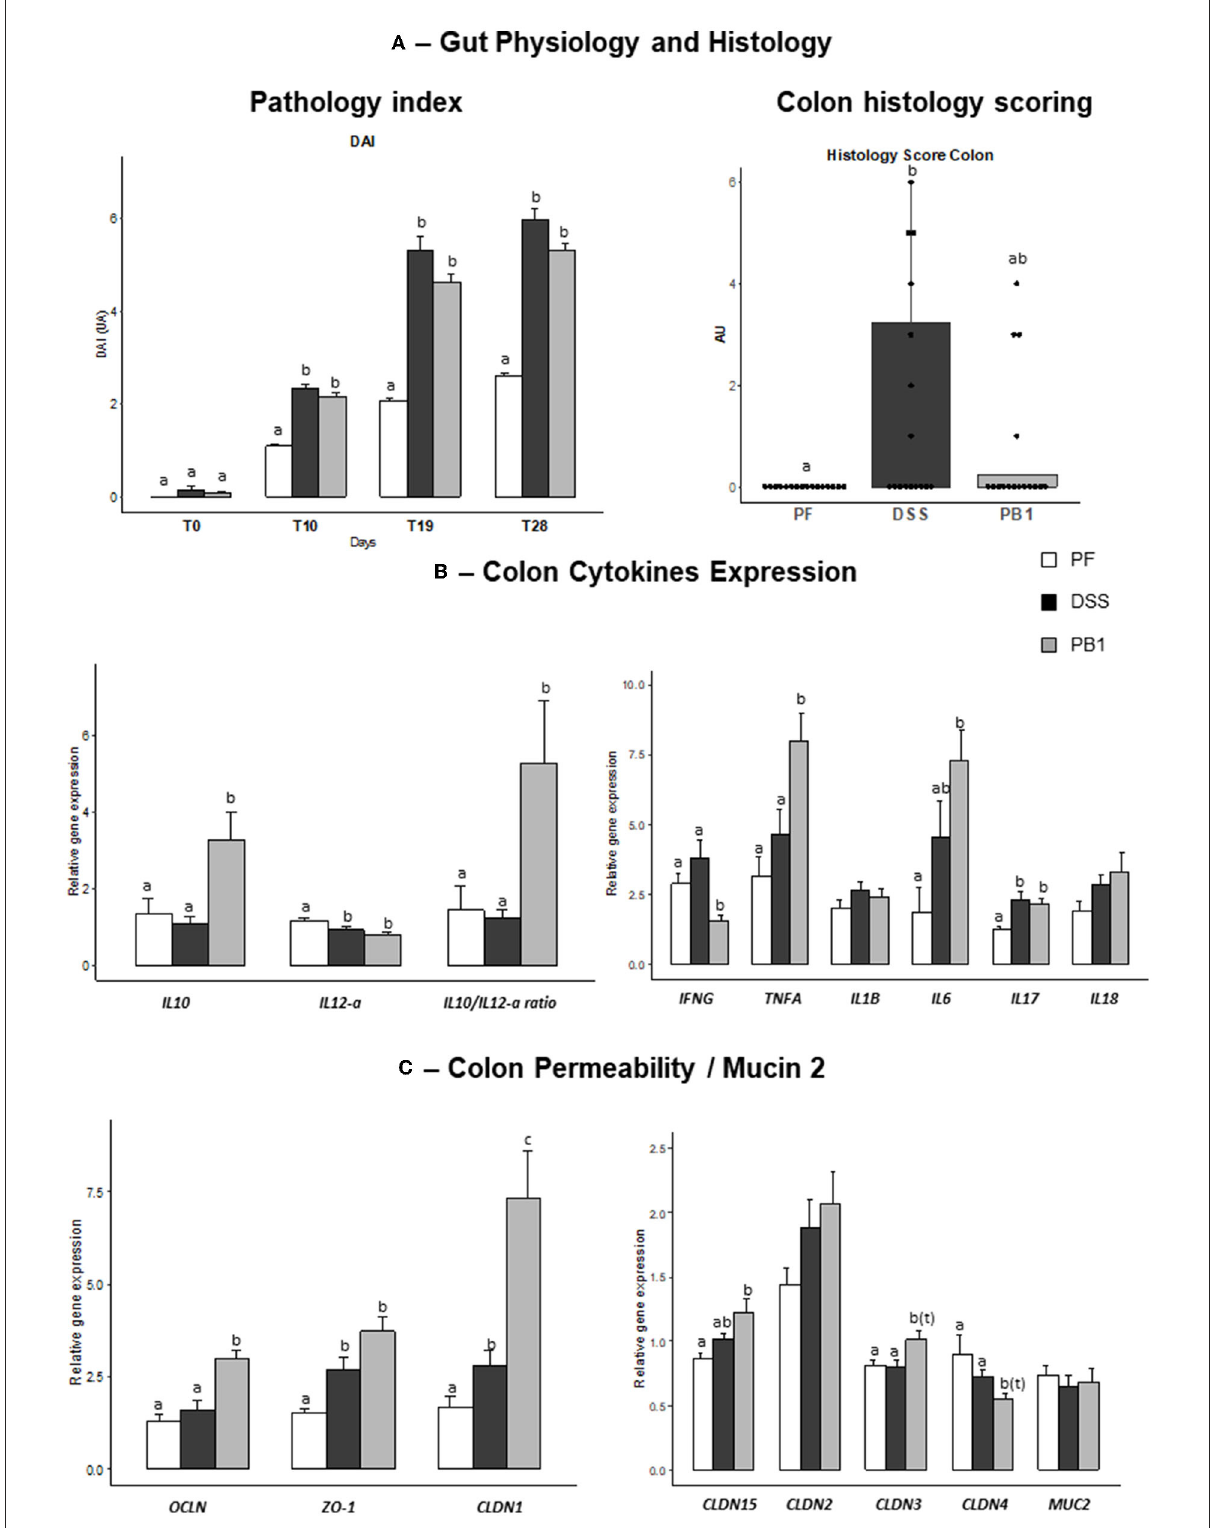
FIGURE3 Impact of Dextran sodium sulfate with (PB1) or without probiotic supplementation (DSS) on colon physiology, histology and mRNA levels in adult older rats. (A) Evolution of rats pathology index (DAI; AU) and colon histology scoring (AU), (B) Evolution of rats colon cytokine mRNA levels